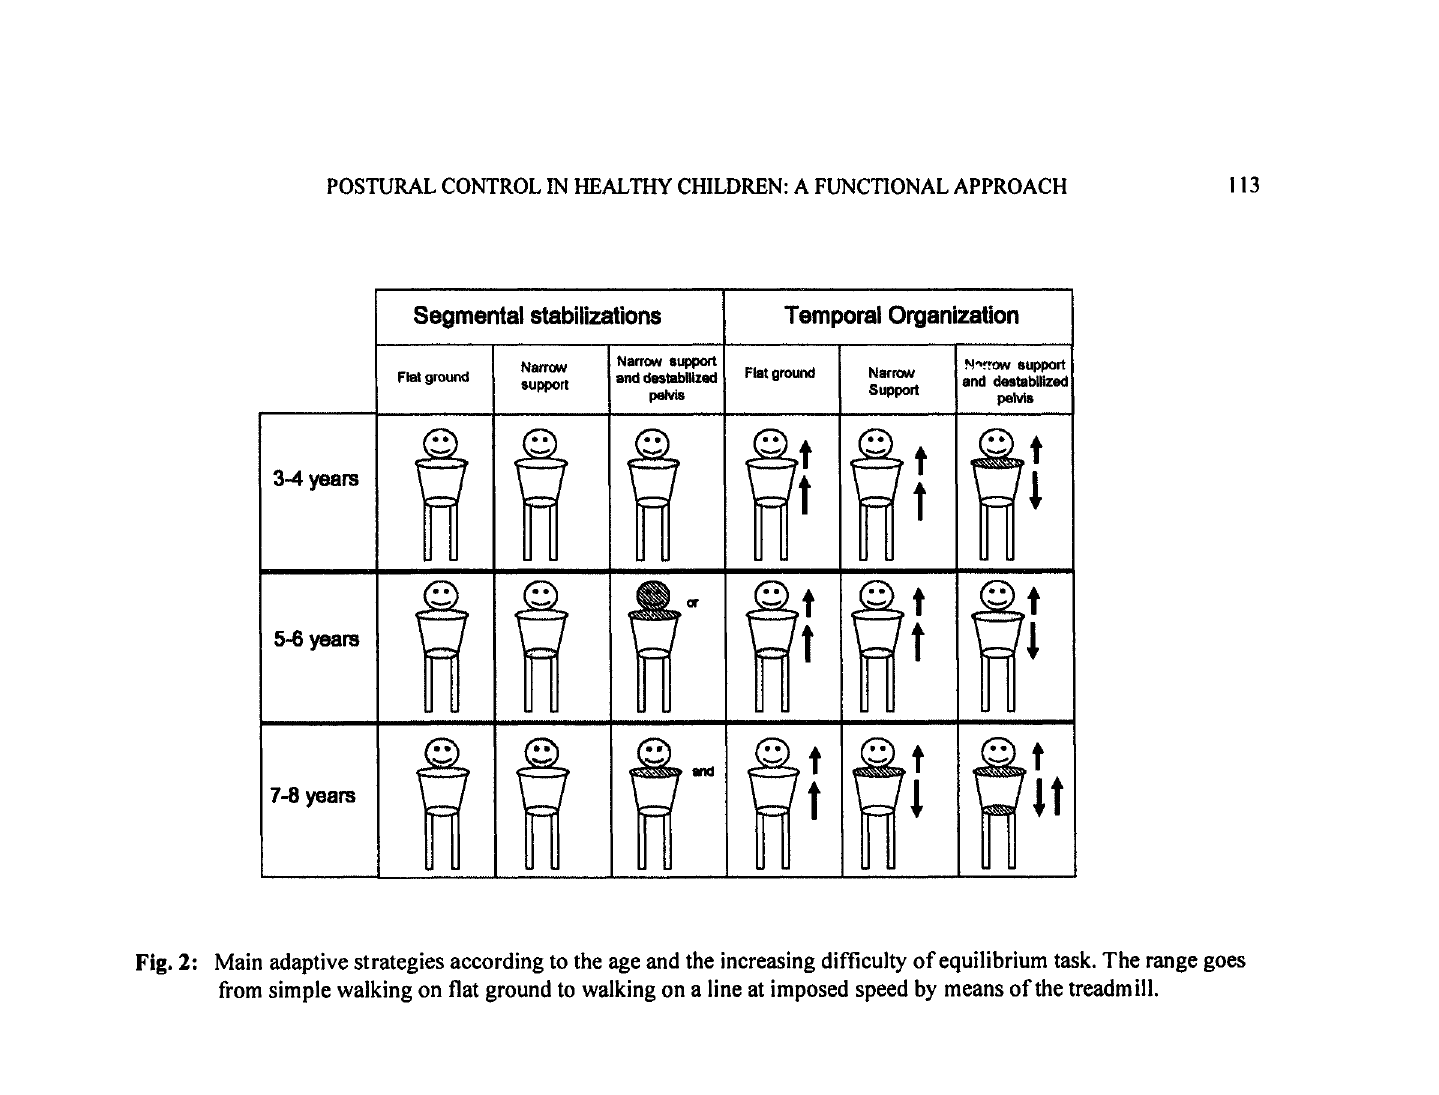
Fig. 2: Main adaptive strategies according to the age and the increasing difficulty of equilibrium task. The range goes from simple walking on flat ground to walking on a line at imposed speed by means of the treadm